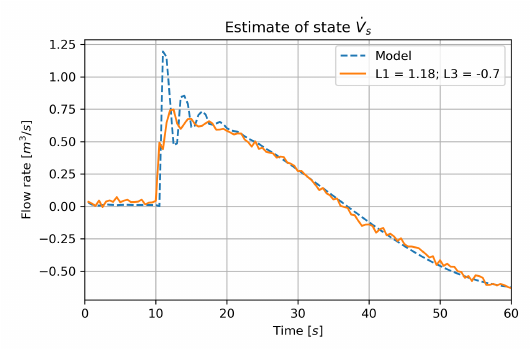
Figure 11: Observer behavior when both measurement x 1 and x 3 are injected. Measurements with noise from the more detailed hydropower